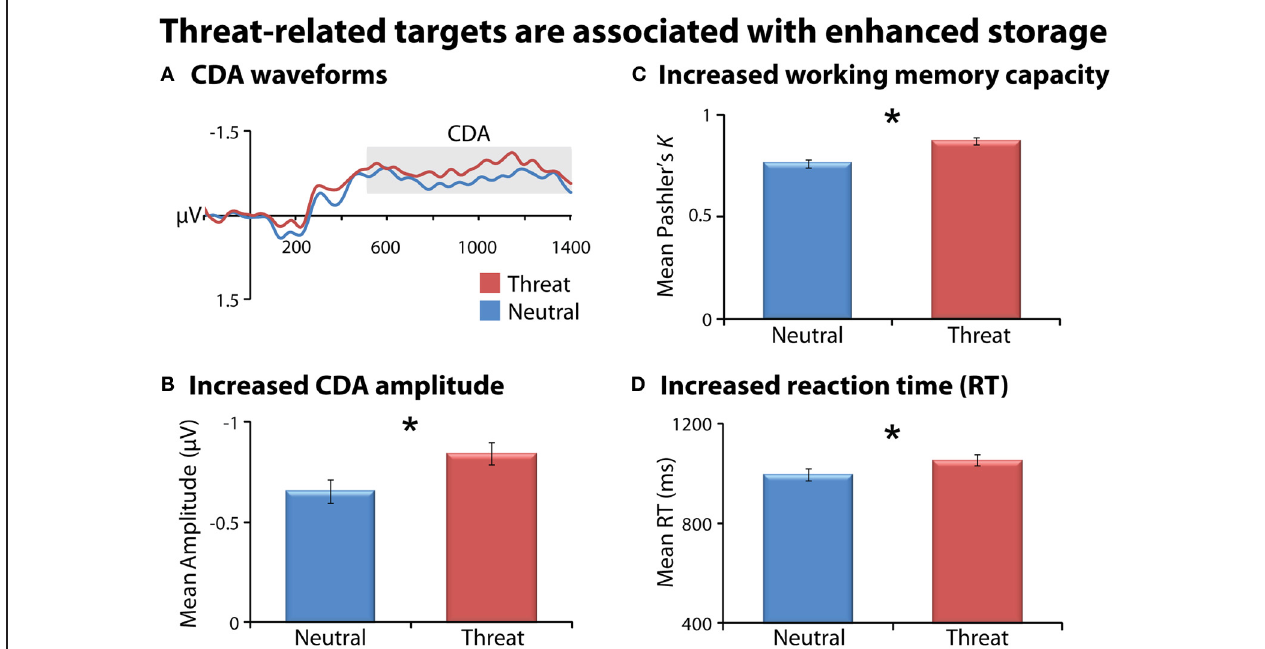
FIGURE 2 | Task-relevant threat targets are associated with enhanced storage. Means are collapsed across set-size (NT1/NT2 and FT1/FT2). Contralateral delay activity (CDA) waveforms (panel A ). Mean CDA amplitude was extracted using the entire delay interval (500–1400 ms; gray box). Threat (red) was associated with increased CDA amplitude (panel B ), working memory capacity (panel C ), and reaction time (RT; panel D ) compared to